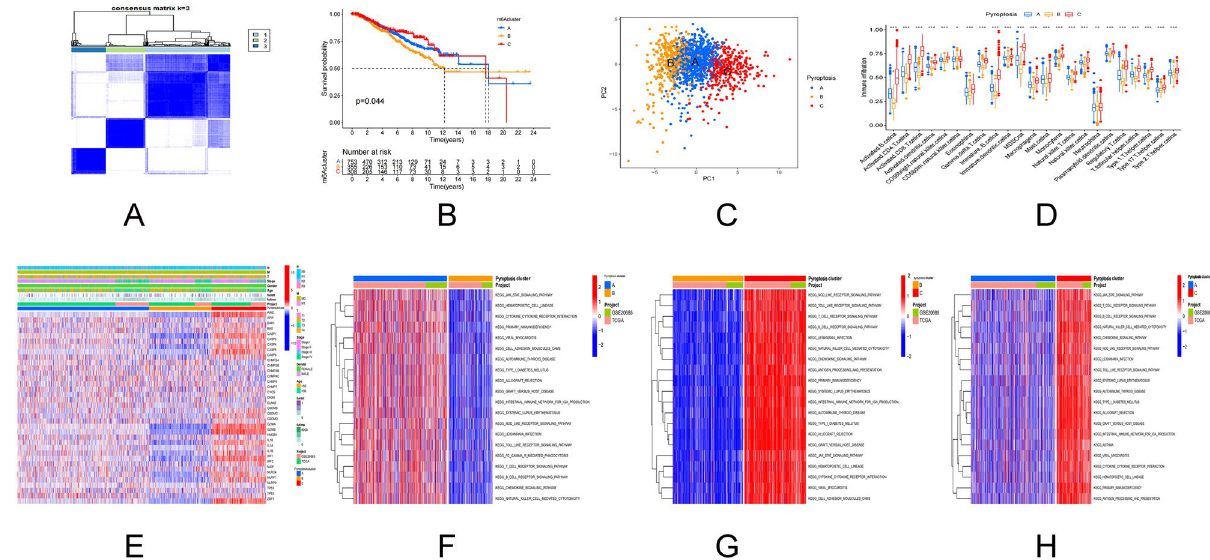
Figure 2. PRGs subtypes and clinicopathological features. ( A ) Consensus matrix heat map defining the three clusters (k = 3) and their associated regions. ( B ) Survival analysis of the three subtypes versus OS. ( C ) PCA analysis showing significant differences in transcriptomes between the three subtypes. ( D ) Association of the three subtypes with immune cells infiltration. ( E ) Differences in the three subtypes in relation to clinicopathological features and expression levels of PRG. ( F–H ) GSVA of biological pathways between the three different isoforms, where red and blue represent activating pathways and blue represent inhibiting pathways, respectively. PCA principal component analysis, OS overall survival.